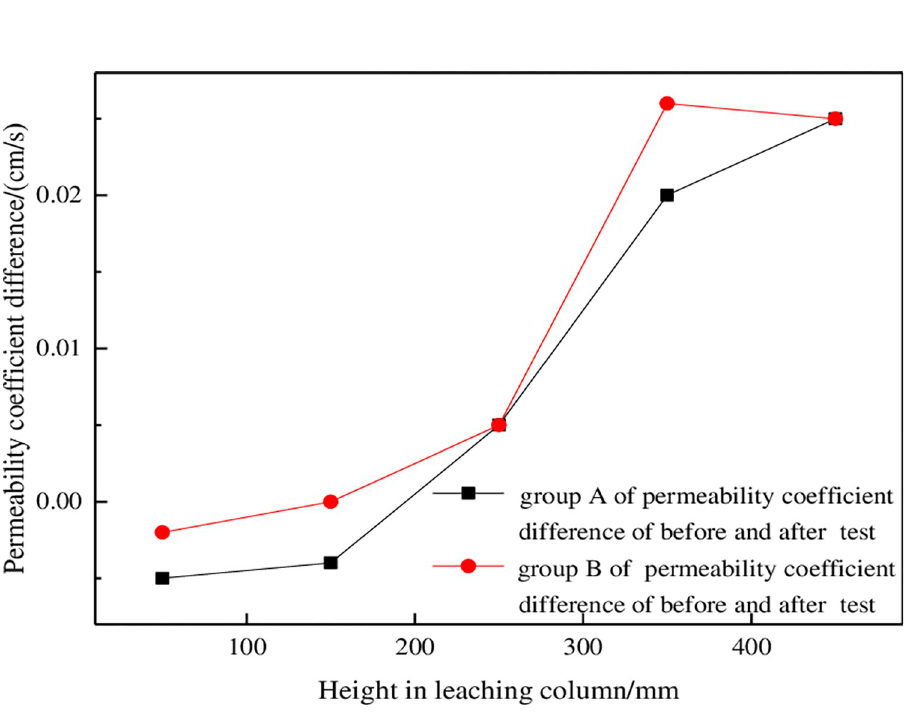
Fig 9. Permeability coefficient differences before and after testing of groups A and B.